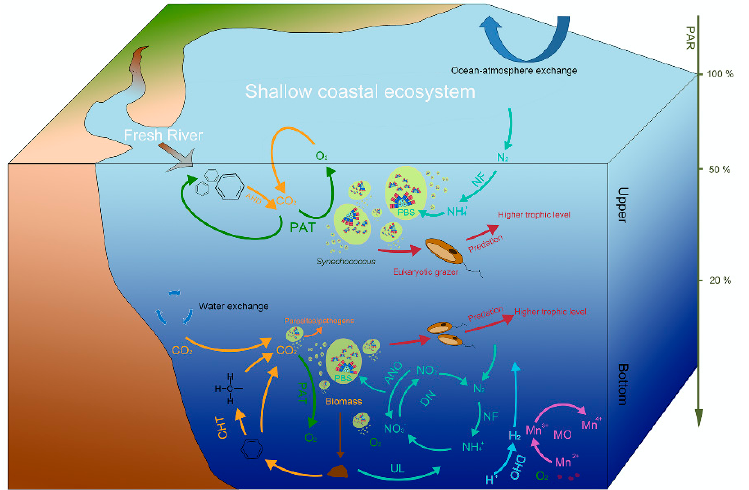
Figure 6. Schematic diagram illustrating the coupling of the biochemical cycles associated with Synechococcus and mediated by microorganisms in the coastal ecosystem. PBS, phycobilisomes; PAR, photosynthetically active radiation; AHD, aromatic hydrocarbon degradation; PAT, photoautotrophy; NF, nitrogen fixation; CHT, chemoheterotrophy; ANO, aerobic nitrite oxidation; UL, ureolysis; MO, manganese oxidation. NO 3 − , nitrate; NO 2 − , nitrite; NH 4+ , ammonium; N 2 , nitrogen; H 2 , hydrogen; CO 2 , carbon dioxide; O 2 , oxygen; Mn, manganese.